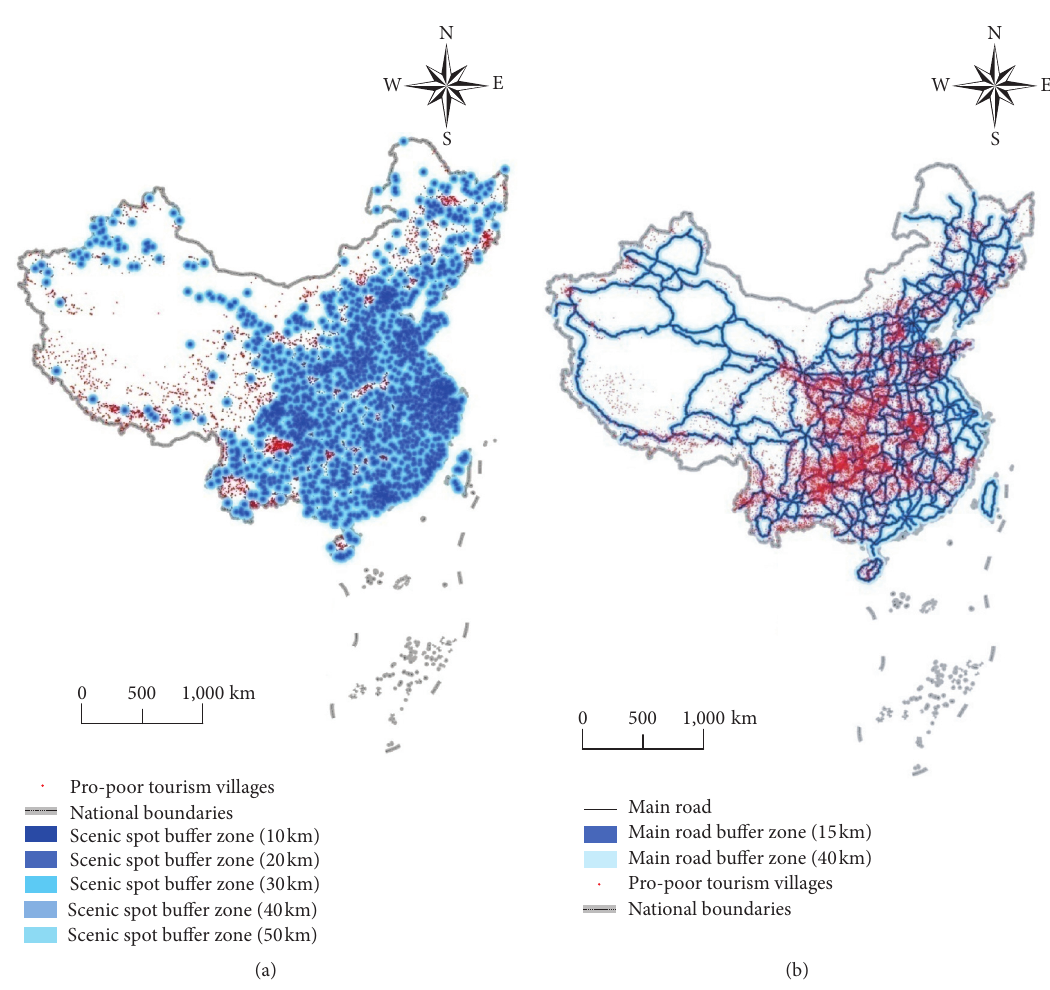
Figure 4: Coupling diagram of high A-level scenic spots buffer zone, main road buffer zone, and pro-poor tourism villages.